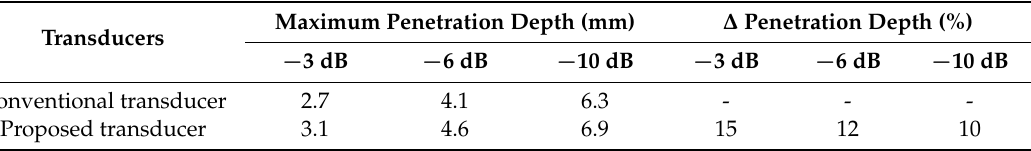
Figure 7. Comparison of simulated pressure pattern for the conventional and proposed transducers.